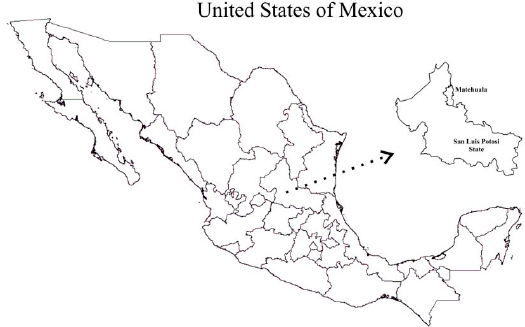
Figure 1. Map of M é xico, which shows Matehuala, SLP. Figure 1. Map of México, which shows Matehuala, SLP. Figure 1. Map of México, which shows Matehuala, SLP.